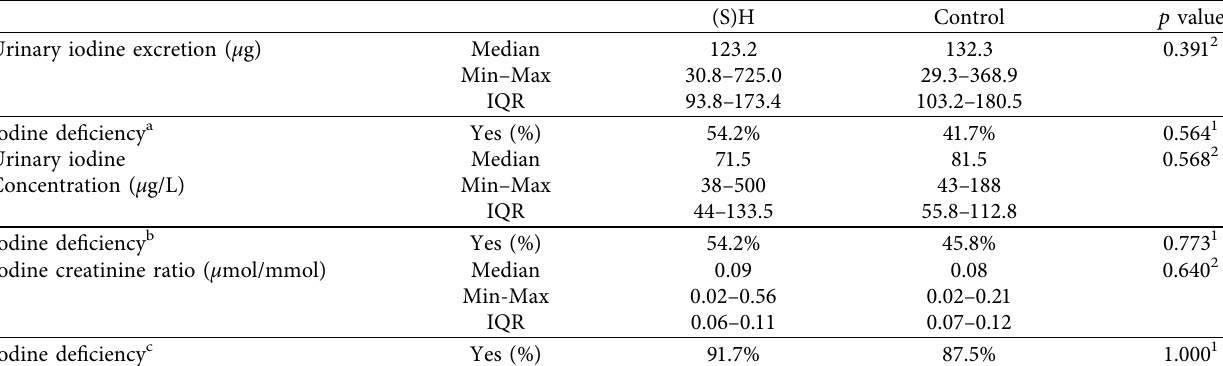
Table 2: Prevalence of iodine